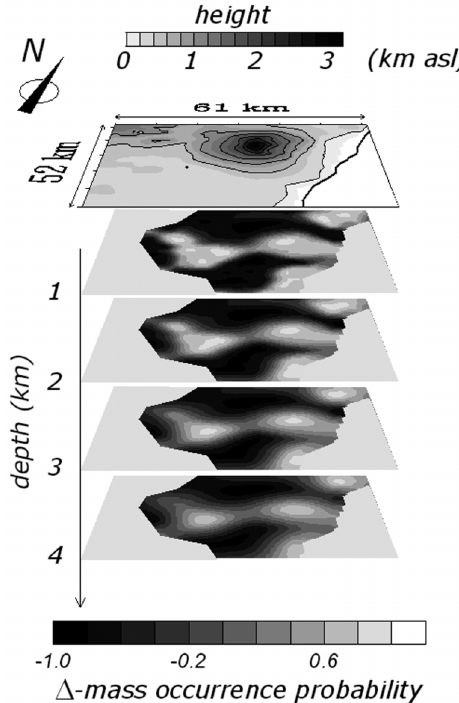
Fig. 11. The Mt. Etna case-history. The gravity source probability tomography. The top slice is the reference topographic map. The following tomo- graphic column refers to the depth range from 1 km